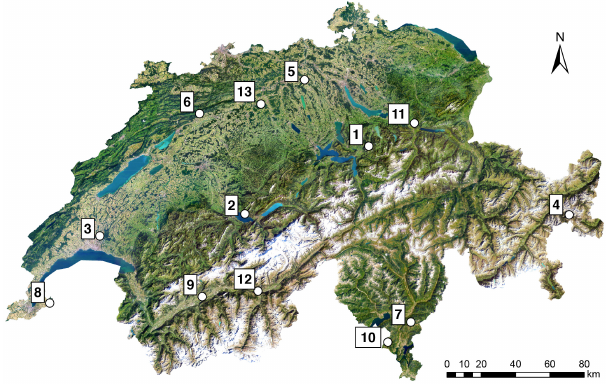
Figure 1. Locations of the sampled sites within Switzerland indicated by white points. Numbers refer to the locations 1 Alpthal, 2 Beatenberg, 3 Lausanne, 4 Nationalpark, 5 Othmarsingen, 6 Bettlachstock, 7 Isone, 8 Jussy, 9 Lens, 10 Novaggio, 11 Schaenis, 12 Visp and 13 Vordemwald (Innes,